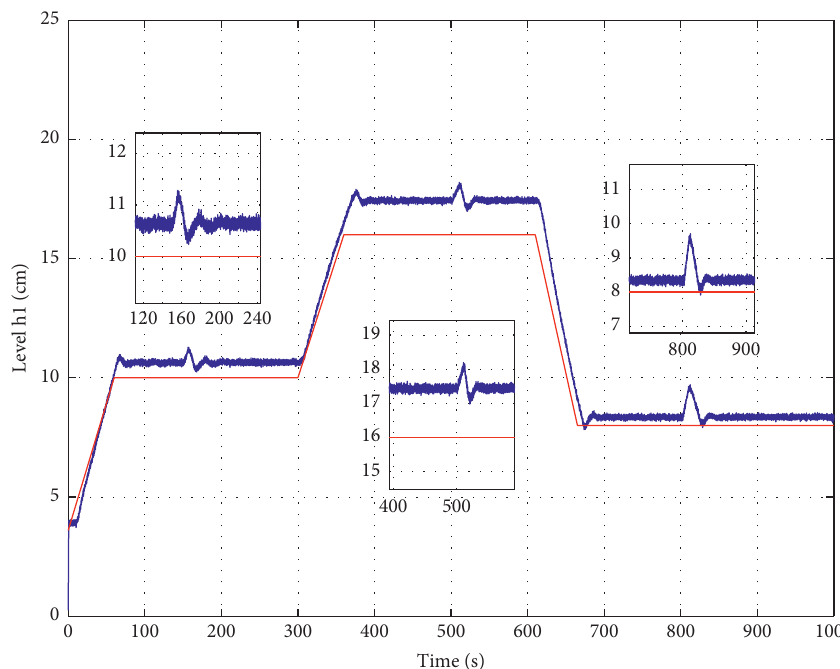
Figure 9: Experimental result for BC tracking and its impact on external disturbance.